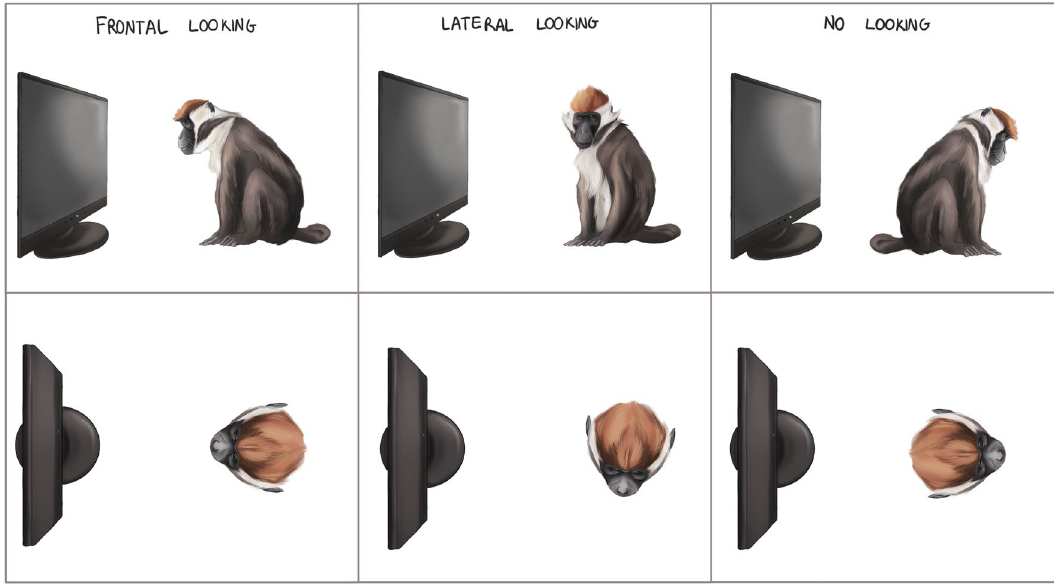
Figure 1. Codification of stimuli perception by means of looking directions during the experimental sessions. Under the FL condition the head of the subject had to be directed towards the screen. Credits Fosca